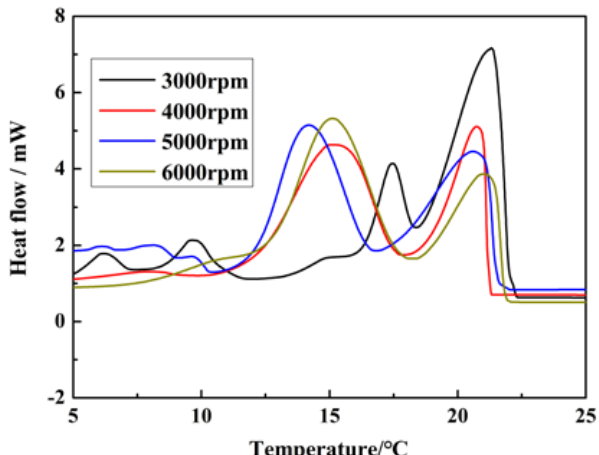
Figure 10. The influence of emulsification stirring speed on DSC crystallization curve of Mi- croPCMs.